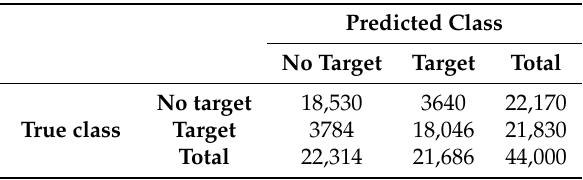
Table 1. Classification table accumulated over the ten trials.